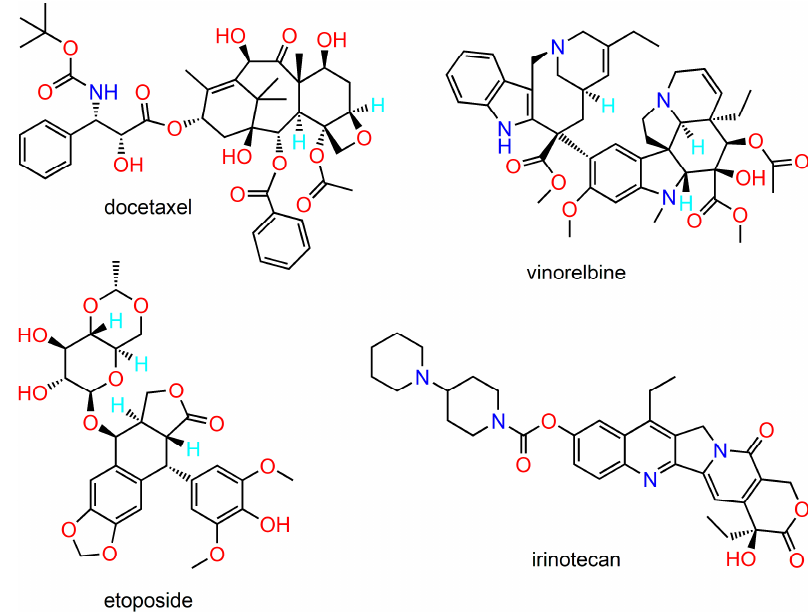
Figure 1. Examples of the main classes of antineoplastic drugs from plants.